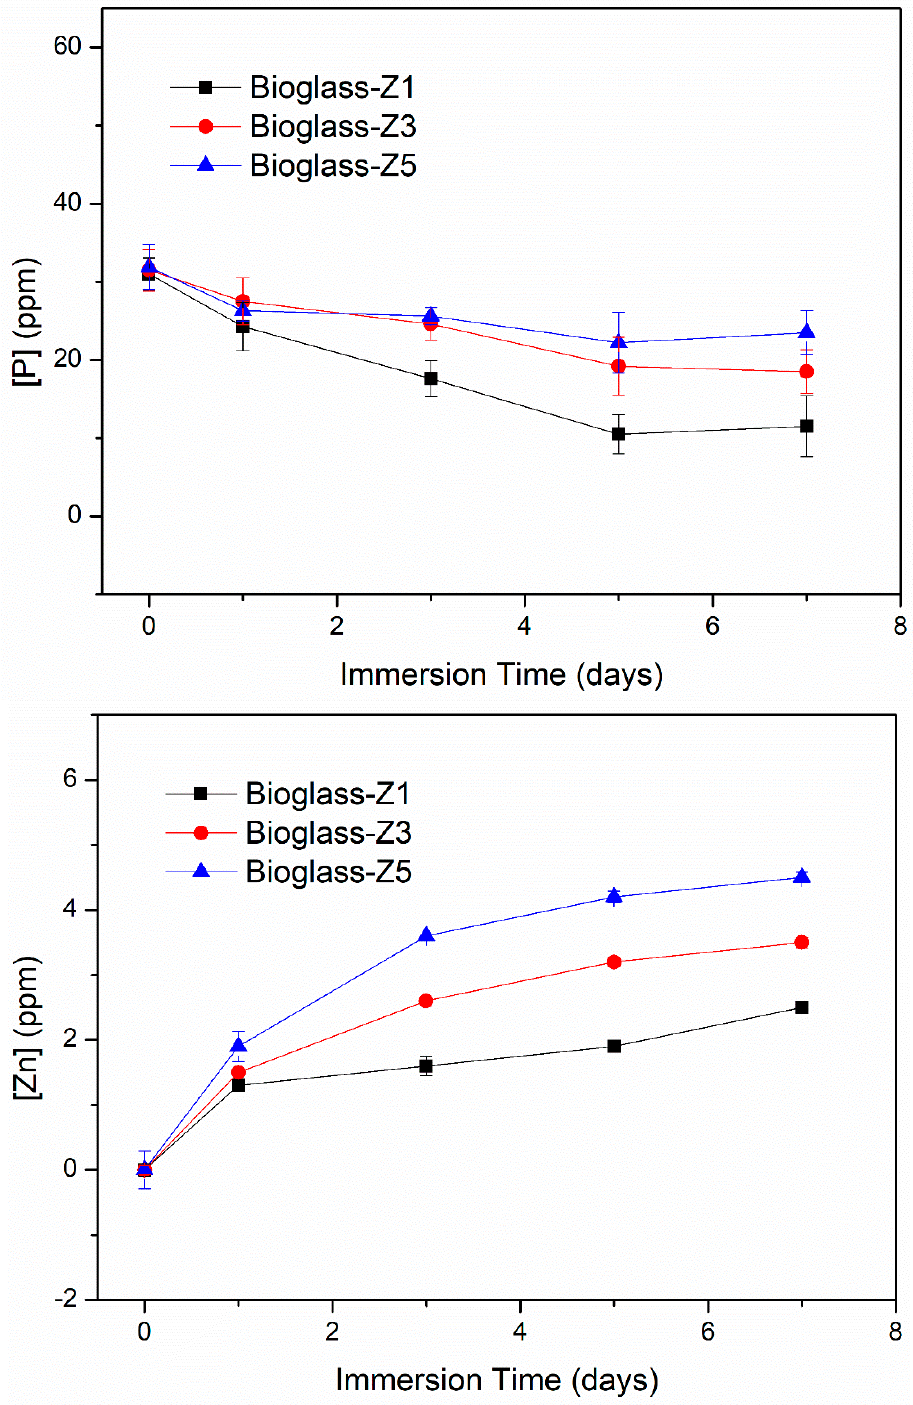
Figure 6. Ionic exchange between bioactive glasses 70SiO 2 –(30-x)CaO–xZnO (mol.%, x = 1, 3, 5) and SBF